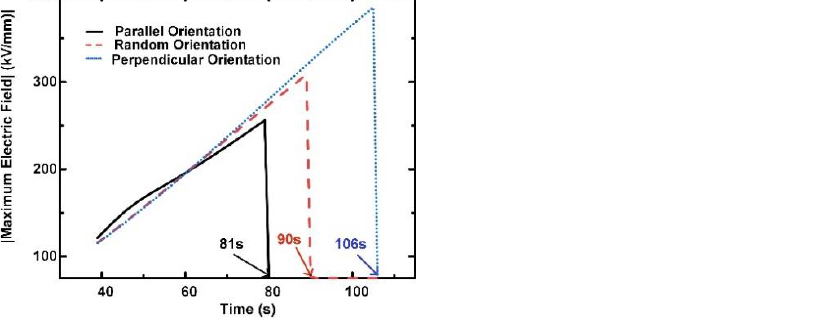
Figure 7. Comparisons of maximum electric field in the polymer with various orientations as a function of time.